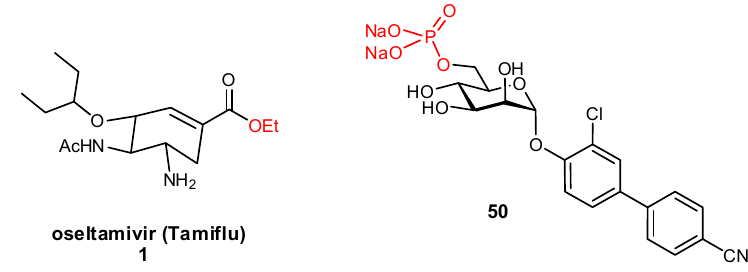
Figure 16. Prodrugs can be used to improve oral bioavailability, by improving factors such as intestinal epithelial membrane permeability ( 1 , ester prodrug) or solubility ( 50 , phosphate prodrug) [125,126] .